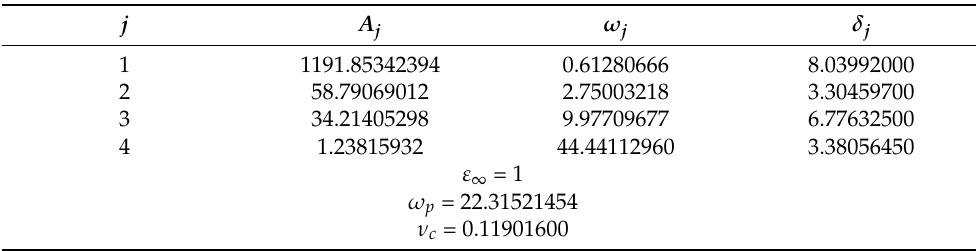
Table 5. Parameters for the Drude–Lorentz’s permittivity model of chromium calculated using experimental results in